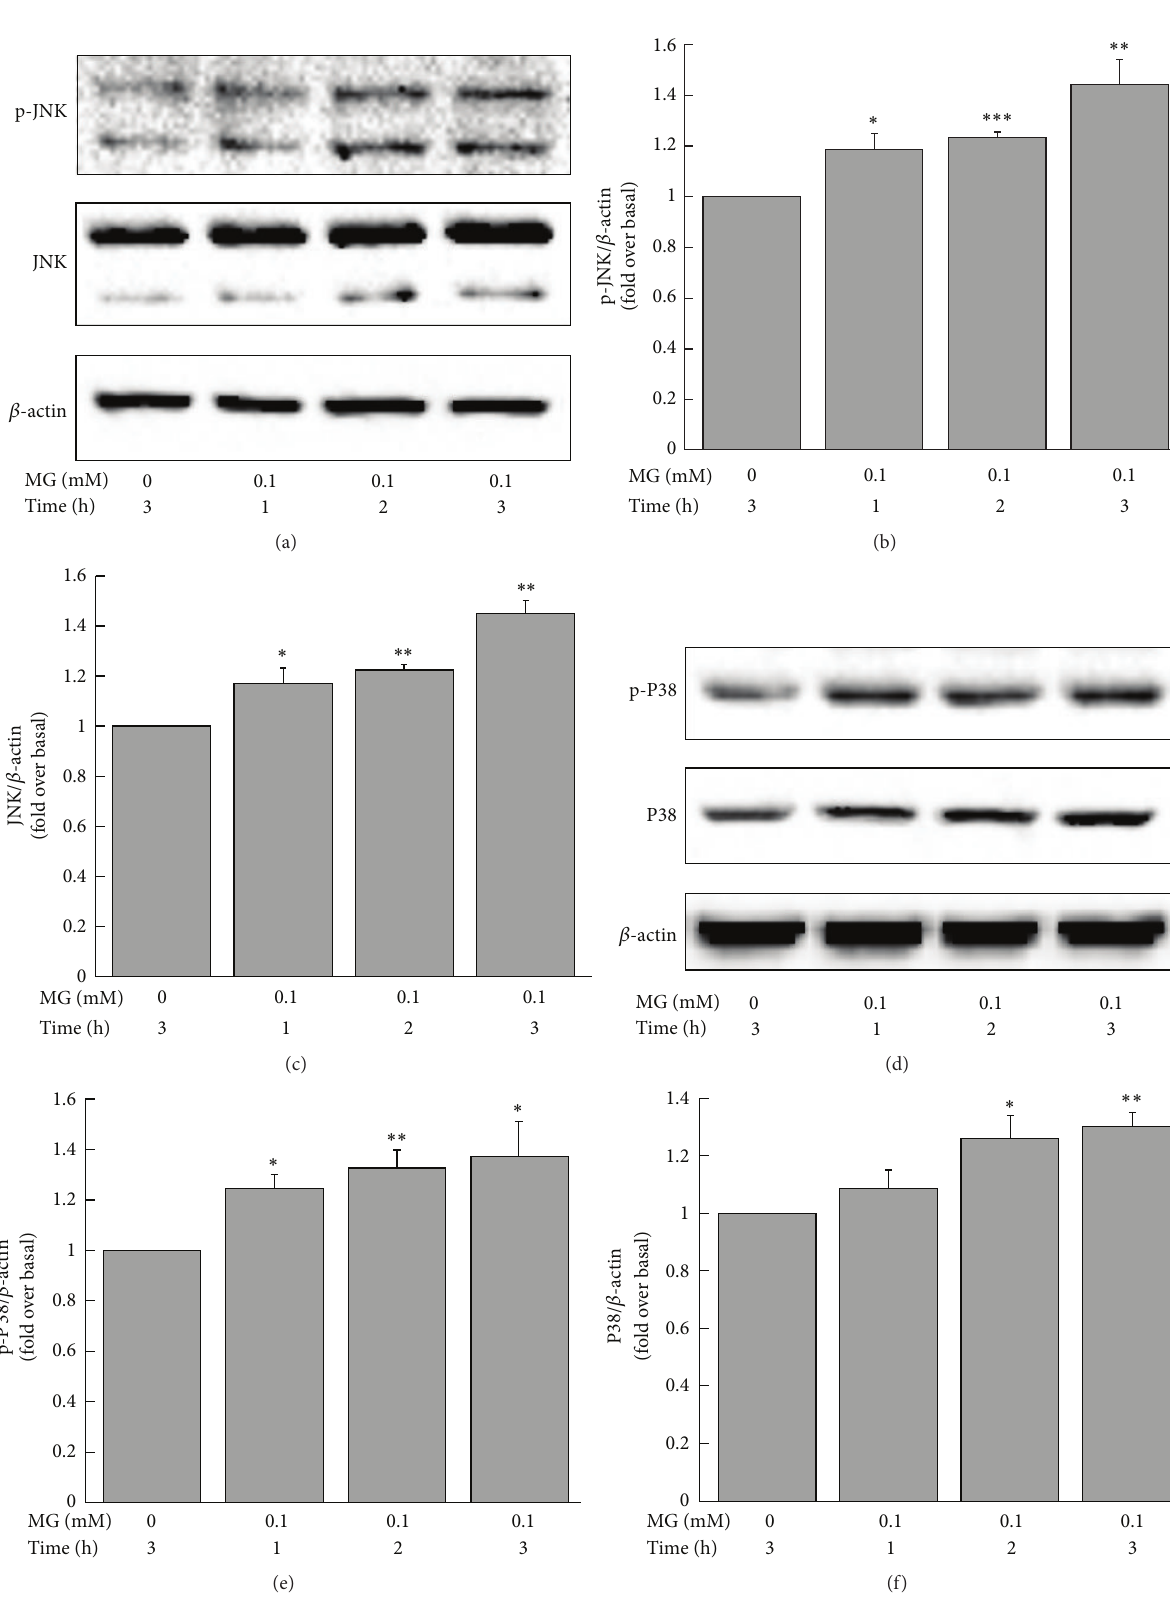
Figure 7: Time-dependent effects of MG on expression of p-JNK, JNK, p-P38, and P38 proteins in MIN6 cells. The expression of p-JNK and JNK (a) and p-P38 and P38 (d) was increased after treatment with MG for 1h. Cells were incubated with 0.1 mM MG for 1, 2, and 3h. Results shown in (b), (c), (e), and (f) are fold change compared to baseline (0 mM MG). ∗ 𝑝 < 0.05 , ∗∗ 𝑝 < 0.01 , and ∗∗∗ 𝑝 < 0.001 compared to control group (0 mM